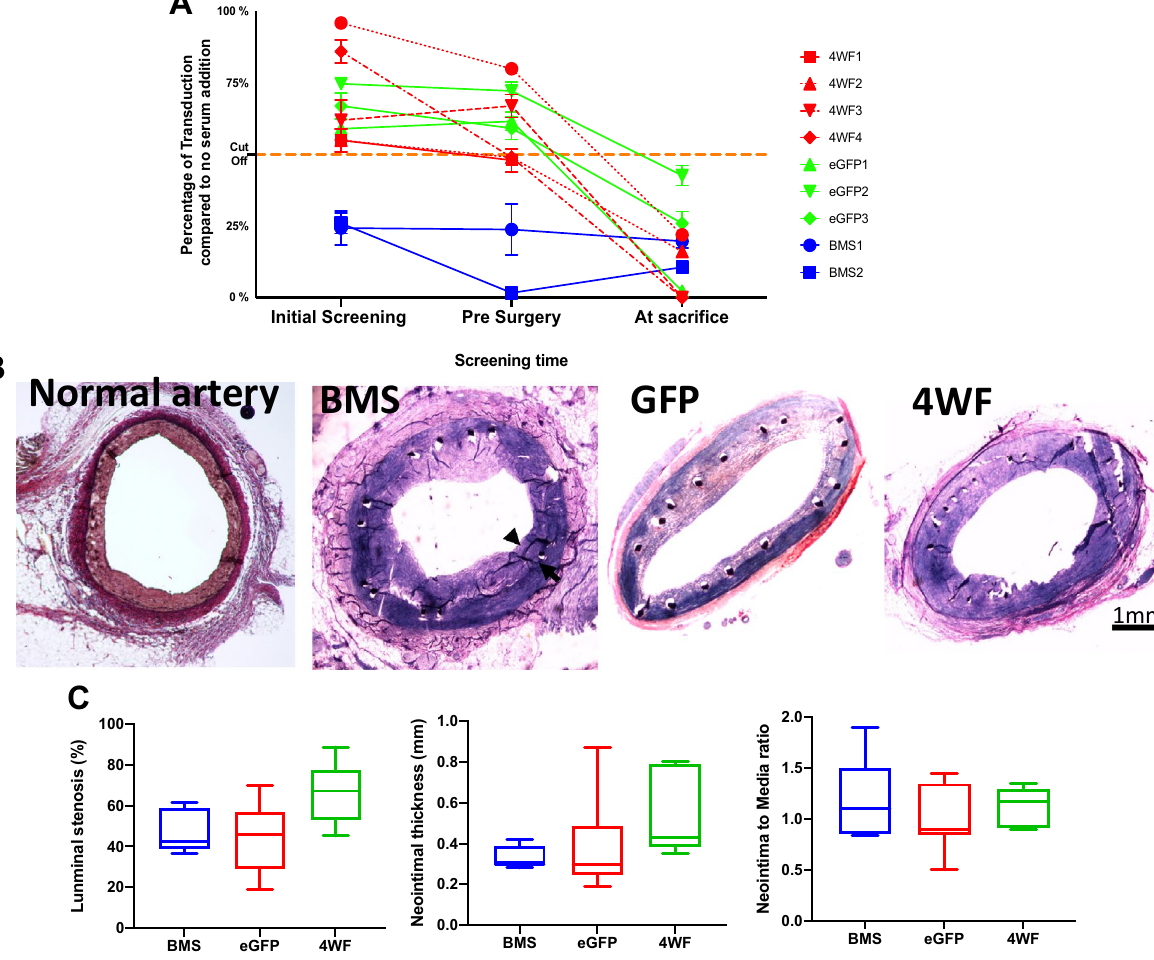
Figure 6. Long-term expression of the therapeutic transgene, the anti-AAV2 neutralizing antibodies dynamics, and the morphometric results in hypercholesterolemic diabetic pigs. ( A ) The percent of retained AAV2eGFP transduction capacity after incubation with 1:20 diluted serum from experimental pigs at different time points throughout the study. NAB positivity was denoted at 50% reduction of transducibility of sera-incubated compared to the not incubated AAV2 vectors. ( B ) Representative images of Verhoeff-van Gieson – stained sections of a normal pig coronary artery and pig coronary arteries treated with BMS, AAV2-eGFP- and AAV2-apoA1(4WF)-eluting stents. ( C ) Morphometric measurements of the stented segments using 3 different calculation methods (percent of luminal stenosis, neointimal thickness, and the ratio of the neointimal area to the medial